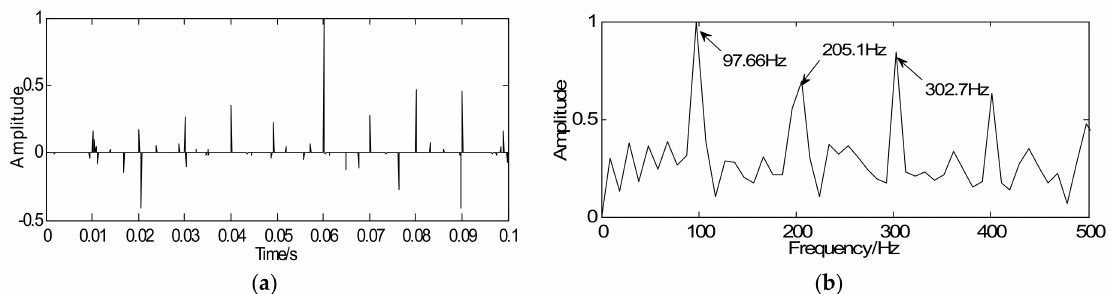
Figure 5. Detection results of simulated signals using the proposed method: ( a ) waveform of sparse signal and ( b ) envelope spectrum of the sparse signal.